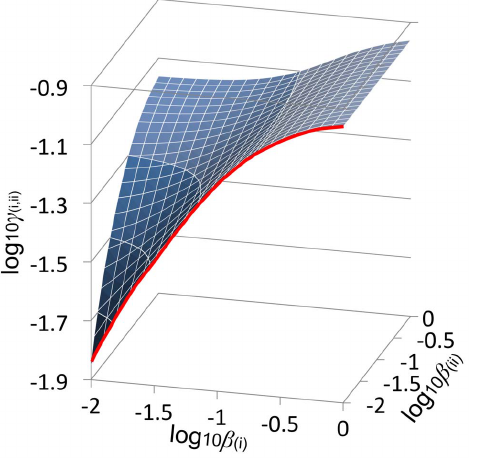
Figure 6. The steady-state surface, which describes the restrictions on the parameters for amylopectin CLD to form. Surface generated for X 0(i) , X min(i) , X 0(ii) and X min(ii) =6, 7, 9 and 14 respectively. These values are the fitted parameters for Figure 2. The thick red line is an approximation to the steady-state line in our previous development (Figure 4 in [24]), where the exact steady-state line is when b (ii) (as defined in Figure 4)=0. c (i,ii) is the sum of relative debranching activities from set (i) and (ii) to that of propagation from set (i) and (ii).